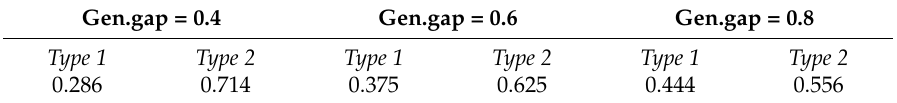
Table 9. The weight of generation gap performance for Type 1 and Type 2 products.